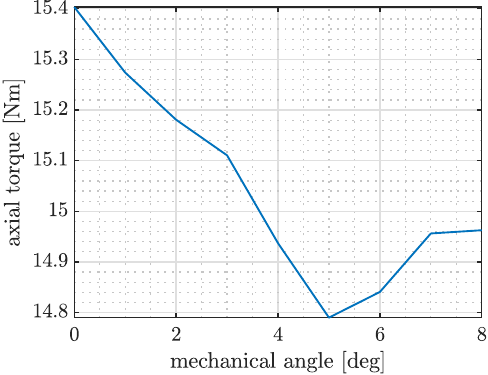
Figure 10. PMSM torque production versus rotor angle span.